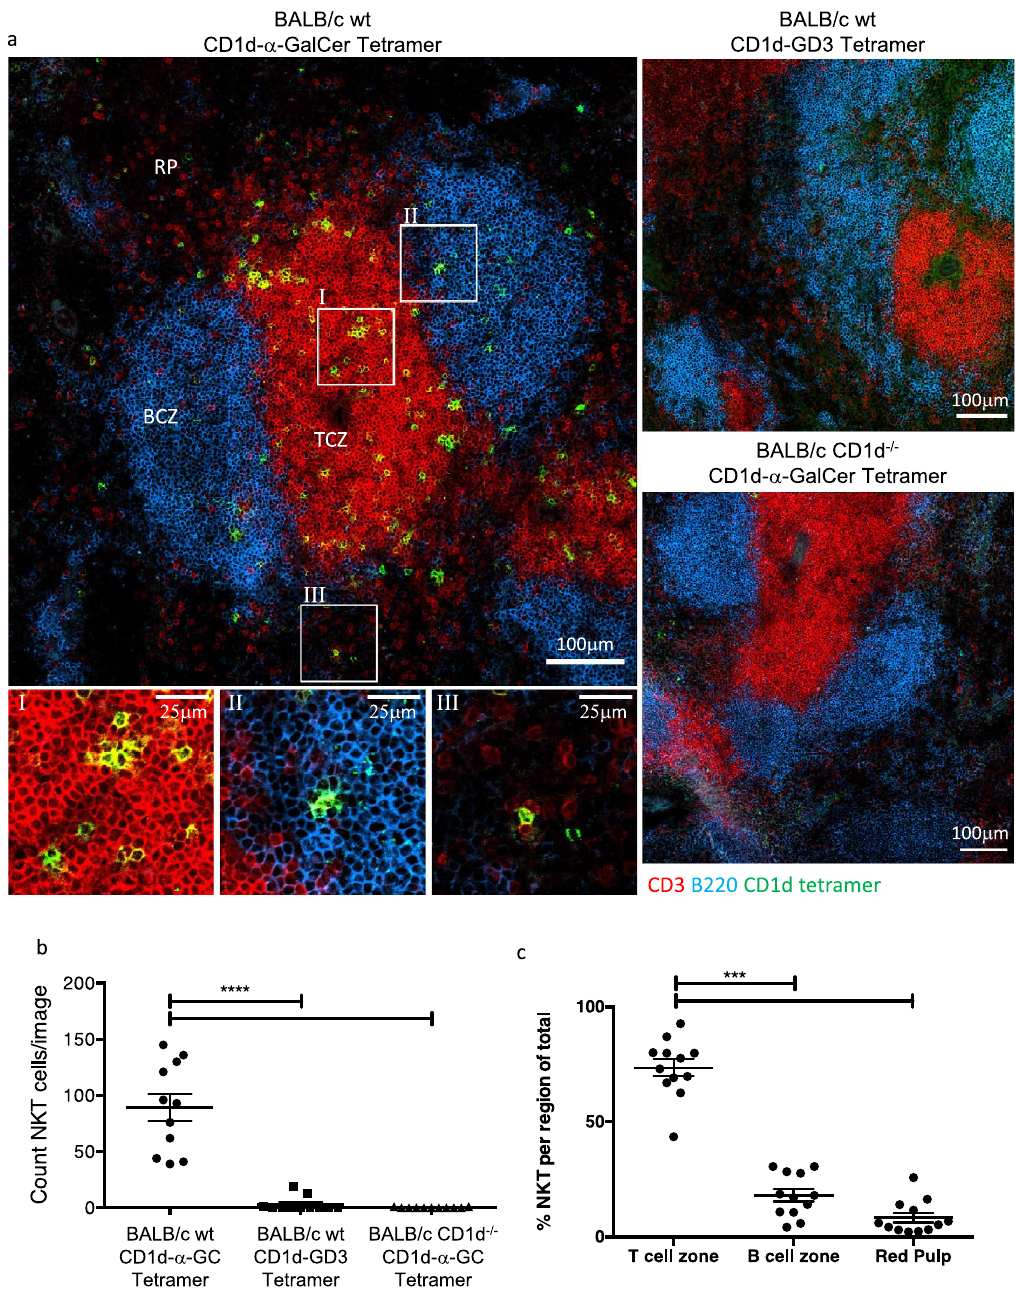
Figure 1. Identification of NKT cells in situ with CD1d-α-GalCer tetramer within BALB/c spleen. Spleen sections from BALB/c WT or CD1d −/− mice stained with CD1d tetramers loaded with α-GalCer or GD3 and anti-B220, CD3 and CD4 antibodies. ( a ) Representative images showing CD1d tetramer (green), B220 (blue) and CD3 (red) staining within splenic red pulp (RP), B cell zone (BCZ) and T cell zone (TCZ). ( b ) Count of CD1d-α-GalCer tetramer + CD3 + NKT cells per 0.63 mm 2 image and ( c ) proportion of NKT cells within each region of the total number of NKT cells per image, one-way ANOVA with Tukey post-hoc test. ( d ) Representative FACS plot and histogram showing percentage of NKT cells of total T cells and CD4 expression on NKT cells. Cells gated on live B220 − lymphocytes, Tet = Tetramer. ( e ) Representative image with corresponding zoomed regions of showing CD4 (red) and CD1d-α-GalCer tetramer (blue). ( f ) Representative image of those CD4 + (purple) or CD4 − (green) NKT cells as determined by colocation analysis, CD3 (gray) and B220 (blue). ( g ) Mean proportion of CD4 + to CD4 − NKT cells within each splenic region. Image scale bars 100 μm with corresponding zoomed regions of interest scale bar 25 μm. Microscopy images acquired with Zen 2012 (ZEISS ZEN Microscope Software for Microscope Components) and processed with FIJI/ImageJ (Fiji (imagej.net)) and Imaris 9.3 (Microscopy Image Analysis Software—Imaris—Oxford Instruments (oxinst.com)) and figure compiled with Microsoft PowerPoint